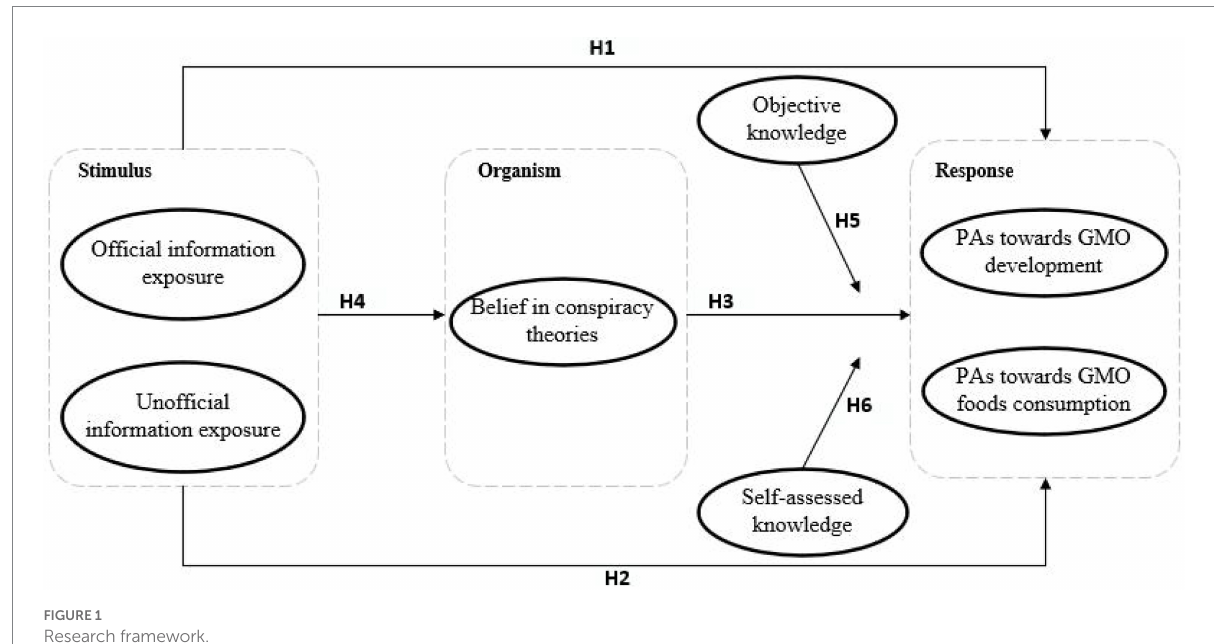
FIGURE 1 Research